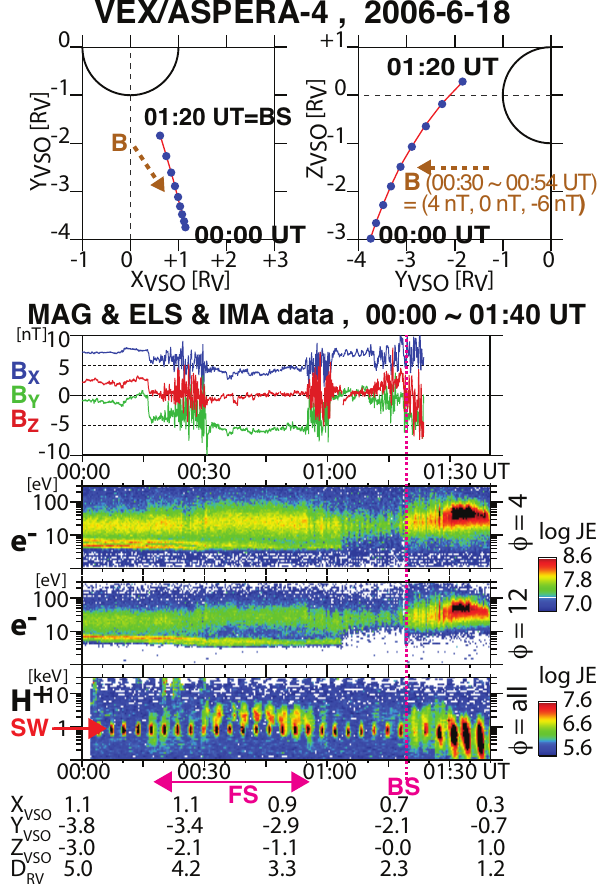
Fig. 3. Overview of the VEX orbit, magnetic field, and hot plasma data (bottom three panels) on 18 June 2006 during 00:00 ∼ 01:40UT. The two top panels show the VEX orbit in the VSO coordinate system (see text for definition). The VEX traversal is drawn by a red line with ticks every 10min. The unit R V is the Venus radius. The second panel shows the magnetic field X (blue), Y (green), and Z (red) components in the VSO coordinate. The bot- tom three panels show energy-time spectrograms of the energy flux (keVcm − 2 s − 1 keV − 1 ) of electrons (two opposite directions) and protons (average of all 16 azimuthal directions). The nearly 3-min (192s) cycle seen in the IMA data is due to the scanning cycle of the IMA entrance (elevation) direction from θ = 0 to θ = 15. The solar wind protons (SW) are seen at around 1keV every 192s scan- ning cycle. The bow shock (BS) is crossed at around 01:20UT, and foreshock ions (FS) are observed at around 00:15 ∼